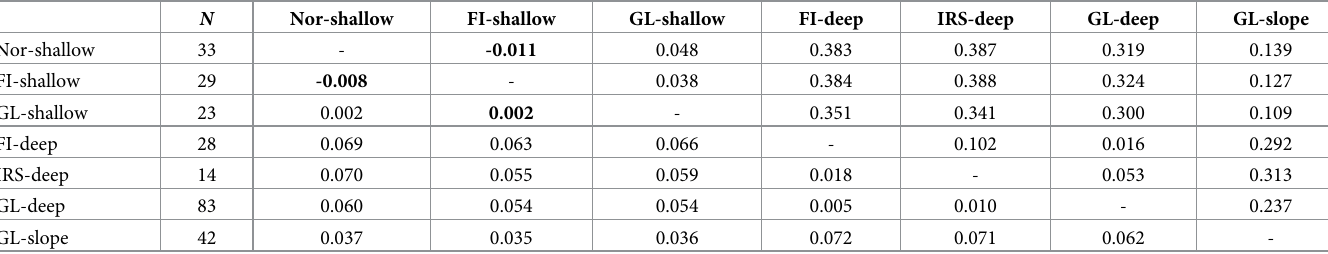
The ‘shallow’, ‘deep’ and ‘slope’ ecotypes identified from different sampling locations (cf. Table 1) are compared. F ST estimates using 1,943 neutral (below diagonal) and 97 outlier (above diagonal) SNPs are presented. Values except those in bold are statistically significant ( P � 0.05) even after FDR (= 0.05) control. N = collection sizes.